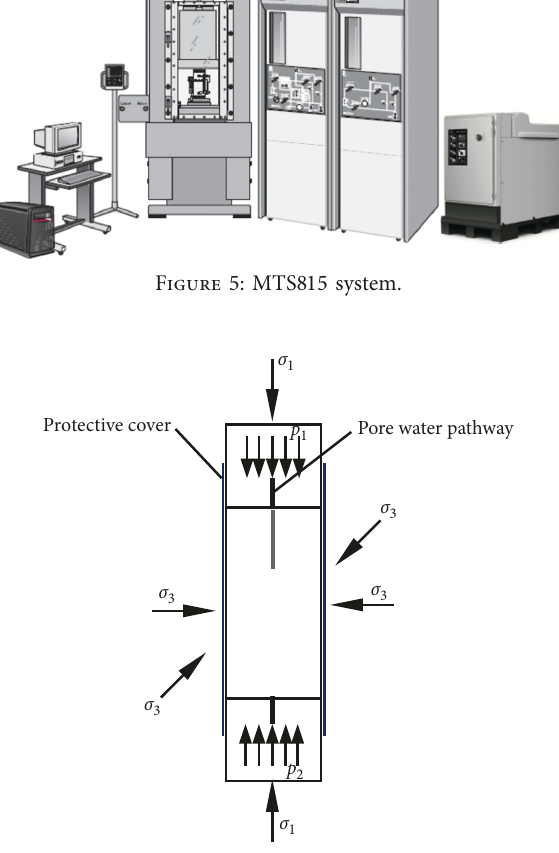
Figure 6: Rock sample in the seepage test